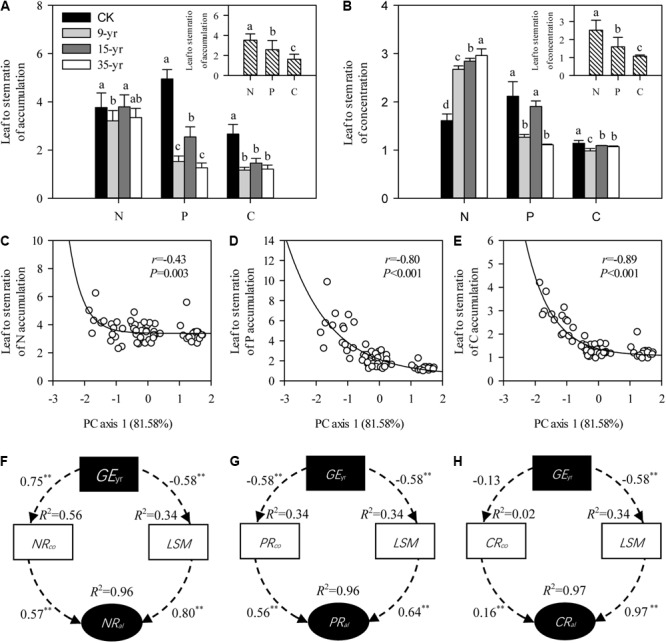
Effects of grazing exclusion on the N, P, C allocations in leaves and stems of Leymus chinensis individuals (mean ± SD). (A) Leaf to stem ratios of N, P, and C accumulation in response to grazing exclusions. (B) Leaf to stem ratios of N, P, and C concentration in response to grazing exclusions. (C–E) Relationships of plant traits (PC axis 1) with leaf to stem ratios of N, P, and C accumulation, respectively. (F–H) Pathways of the changes in leaf to stem ratios of N, P, and C accumulation induced by grazing exclusions, respectively. Values associated with arrows represent standardized path coefficients. R2 values associated with response variables indicate the proportion of variation explained by relationships with other variables. Symbols: ∗∗∗represents P < 0.001. XRco is leaf to stem ratios of N, P, and C concentrations; XRal is leaf to stem ratios of N, P, and C accumulations; CK is open grazing; 9-yr is 9-year grazing exclusion; 15-yr is 15-year grazing exclusion; 35-yr is 35-year grazing exclusion. Different superscripts denote significant differences (P < 0.05).